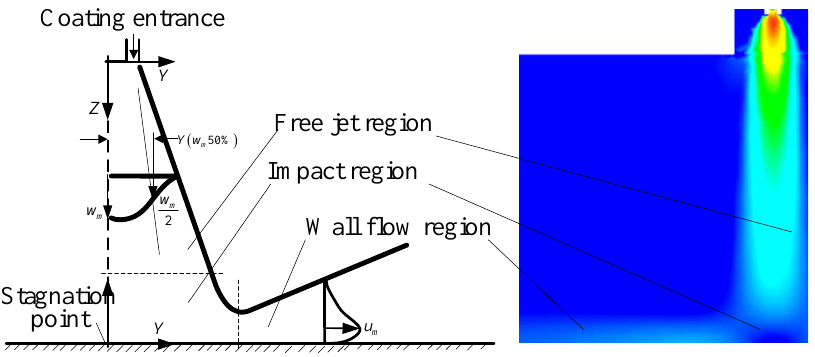
Figure 5. Division of the spray flow field. The half-value width Y (50%) of the velocity is not only an important indicator of the spray velocity along the vertical axis, but also an important indicator to reflect the horizontal expansion of the spray range and the change of the spray width with the vertical axis. The Y (50%) distribution on the central vertical axis is shown in Figure 6.